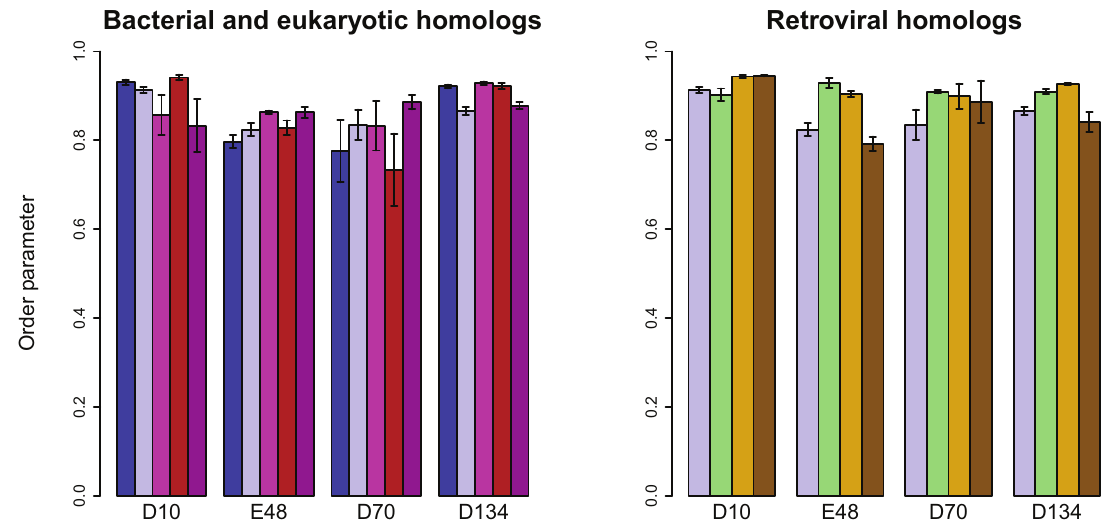
Figure 9. Active-site dynamics in RNase H homologs. Calculated S 2 values are shown for the four active-site residues in RNase H homologs. Left: soRNH (dark blue), ecRNH (light blue), ctRNH (magenta), ttRNH (red), hsRNH (purple). Right: ecRNH (light blue), XMRV WT (green), XMRV ∆ C (yellow), HIV (brown). All simulations were carried out at 300K in the AMBER99SB force field with TIP3P water with structures protonated to reflect a pH of 5.5.